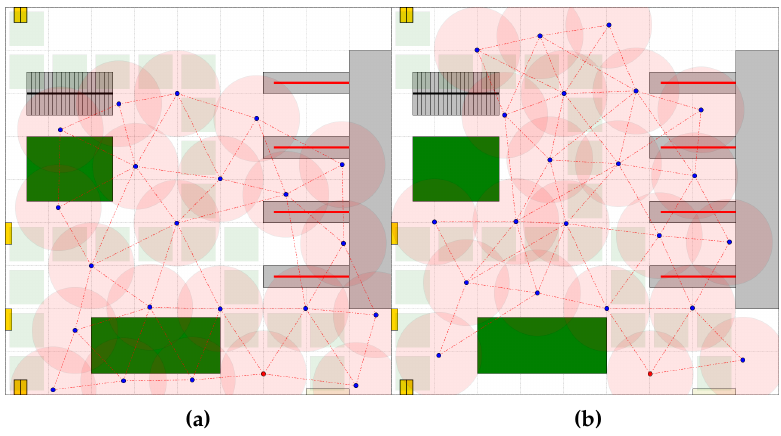
Figure 7. Created network topologies. Hybrid 2 deployment strategy: ( a ) Variant A; ( b ) Variant